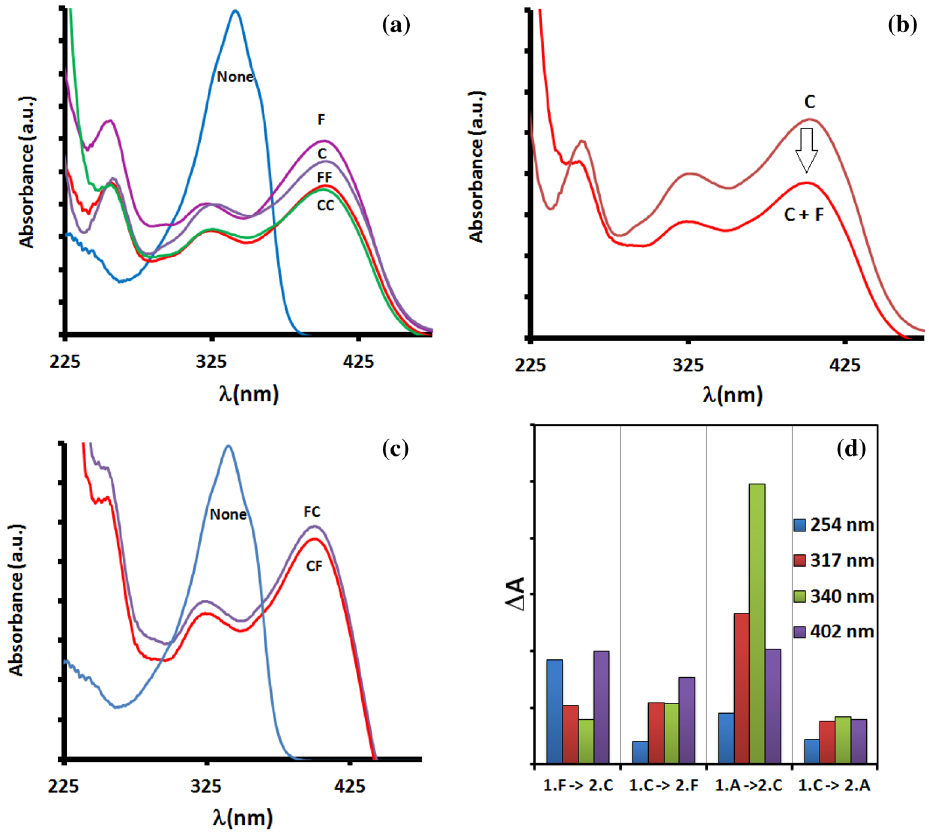
Figure 6. Changes in absorption spectra of 5 (30 µM) upon the addition of ( a ) fluoride (F) and cyanide (C) at different concentration, ( b ) upon changing anion, ( c ) in different orders, ( d ) response of 5 to different sequences of cyanide and fluoride (F) or acetate (A).